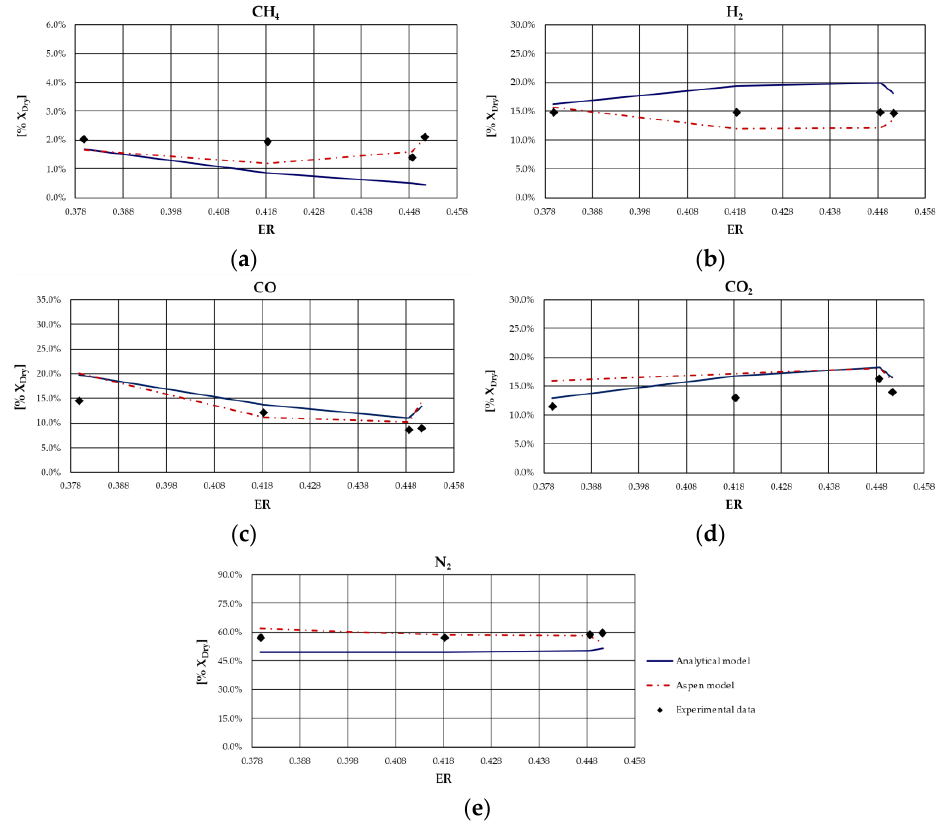
Figure 2. Comparison of syngas mole fraction composition between the results of calibrated and non-calibrated analytical and Aspen models and experimental data from hazelnut shell gasification [66]: ( a ) CH 4 mole fraction; ( b ) H 2 mole fraction; ( c ) CO mole fraction; ( d ) CO 2 mole fraction; ( e ) N 2 mole fraction.